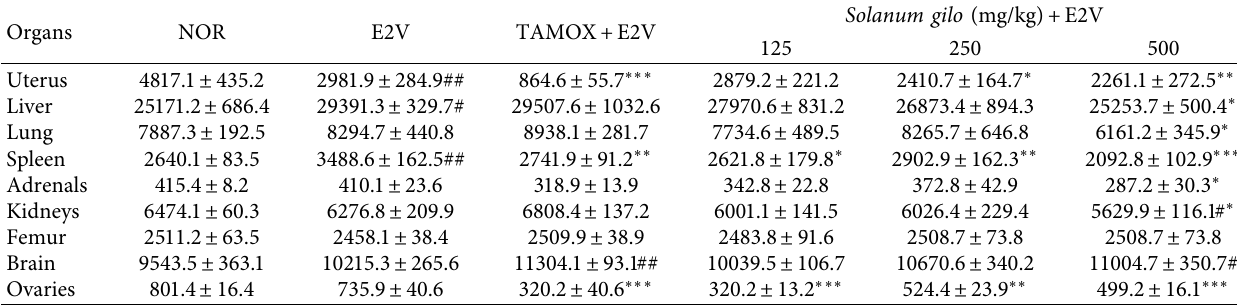
Table 2: Effects of S. gilo hydroethanolic extract on relative wet weight of various organs after 16 weeks of treatment. Organs